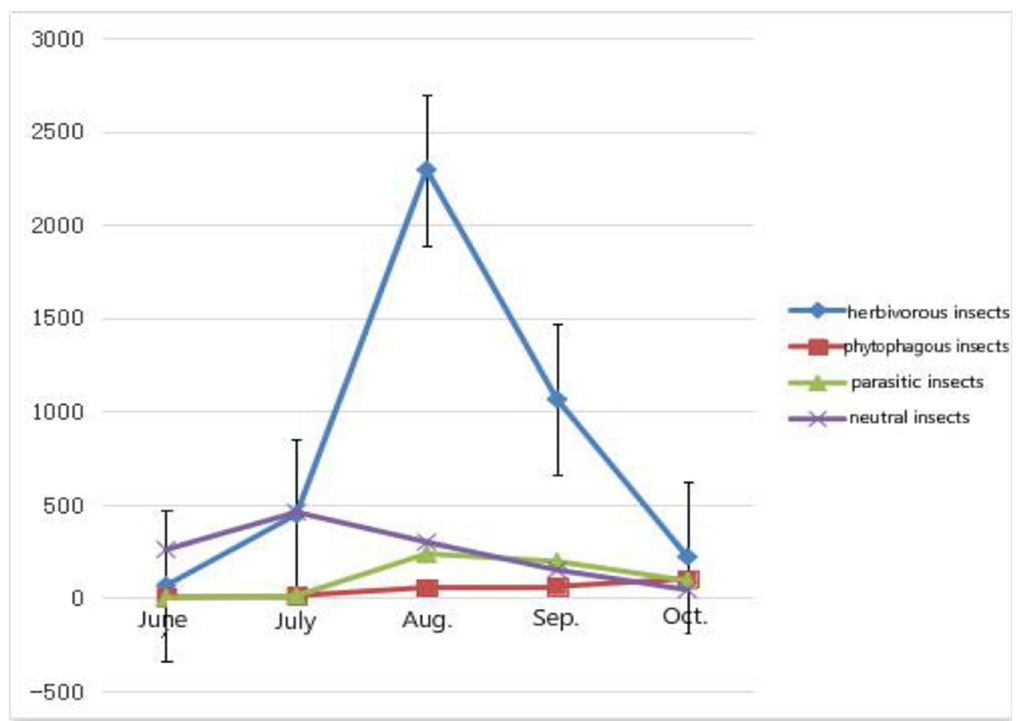
Fig 4. Number of individuals of farm insect functional groups changes with time. The four functional populations of insect communities in corn farmland: herbivorous insects, predatory insects, parasitic insects and neutral insects change with the